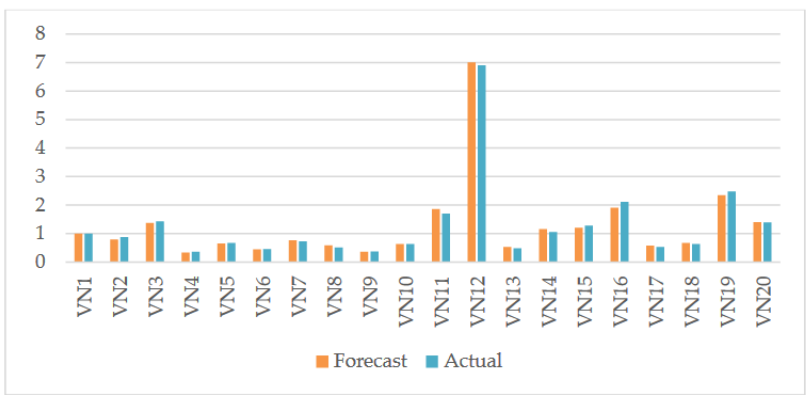
Figure 5. Forecast score and actual 2019 scores (Vietnam).